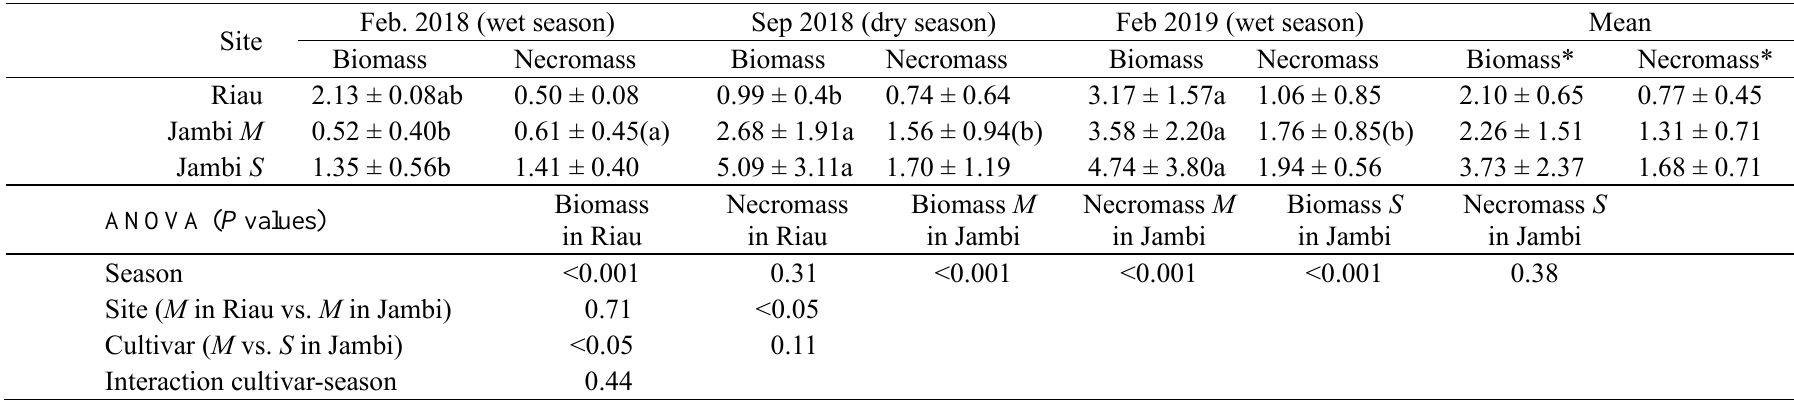
Table 5. Results of Tukey HSD test ( P < 0.05) and ANOVA for biomass and necromass (Mg ha -1 ) of fine roots in Riau, Jambi M and Jambi S (mean ± 1 SD; n = 12 for Feb 2018 in Riau, 36 for Sep 2018 and Feb 2019 in Riau, 24 for M in Jambi, and 12 for S in Jambi). Different suffixes (a, b, etc.) in columns of site mean values (*) denote significant differences between sites ( P < 0.05), and in columns of seasonal mean values denote significant seasonal variations ( P <